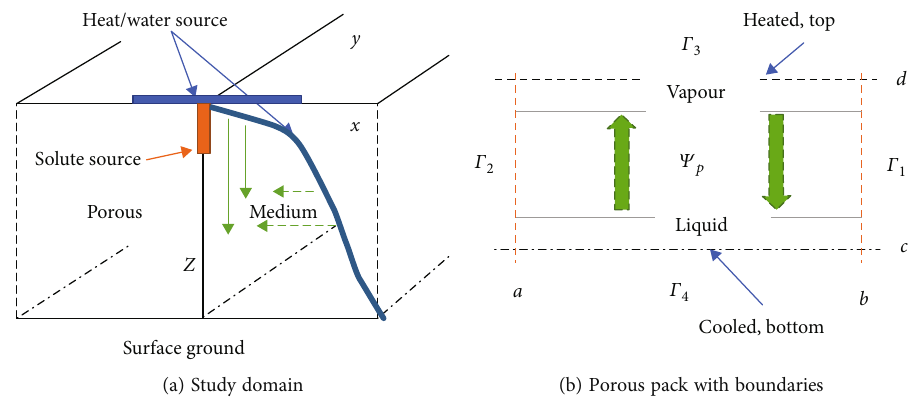
Figure 1: Schematic con fi guration of the homogeneous porous